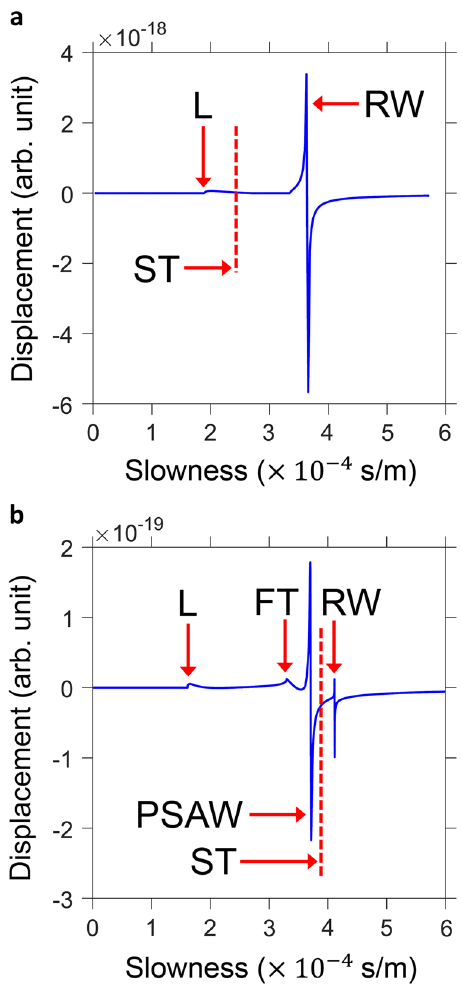
Fig. 2 Computed wave displacement as a function of slowness for pure Ni along a high-symmetry orientation [010] ( a ) and a low- symmetry orientation [0.69, 0.59, − 0.42] ( b ), showing the presence of several wave modes along the low-symmetry orientation. The bulk wave modeling helps identify the bulk L and FT modes and can compute the slowness of the ST mode even though its displacement is too low to be observable along these two orientations. The computed ST mode information is essential for the identi fi cation of the SAW